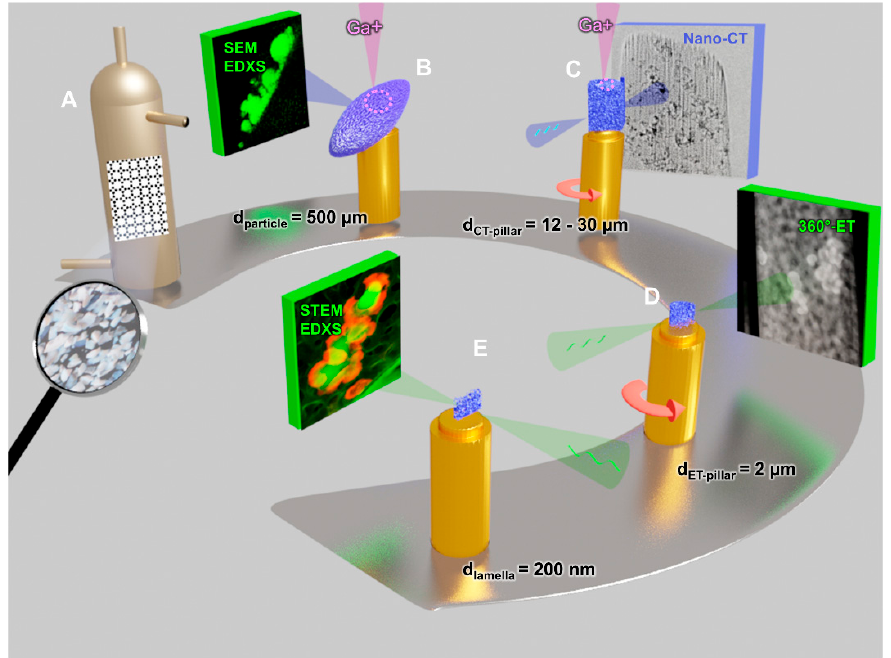
Figure 1. Schematic illustration of the correlative tomography workflow. Combination of several imaging methods enables an in-depth analysis of the SCALMS system over several length scales.